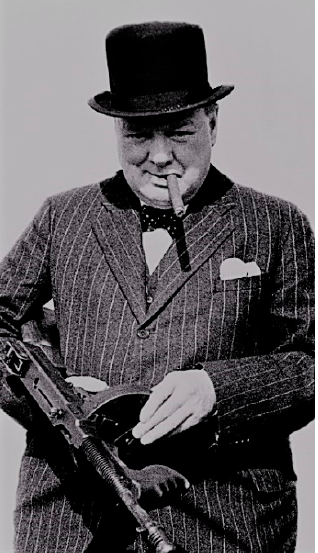
Figure 2. Brecht. 1968. Kriegsfibel . Berlin: Eulenspiegel Verlag. Bild 38.